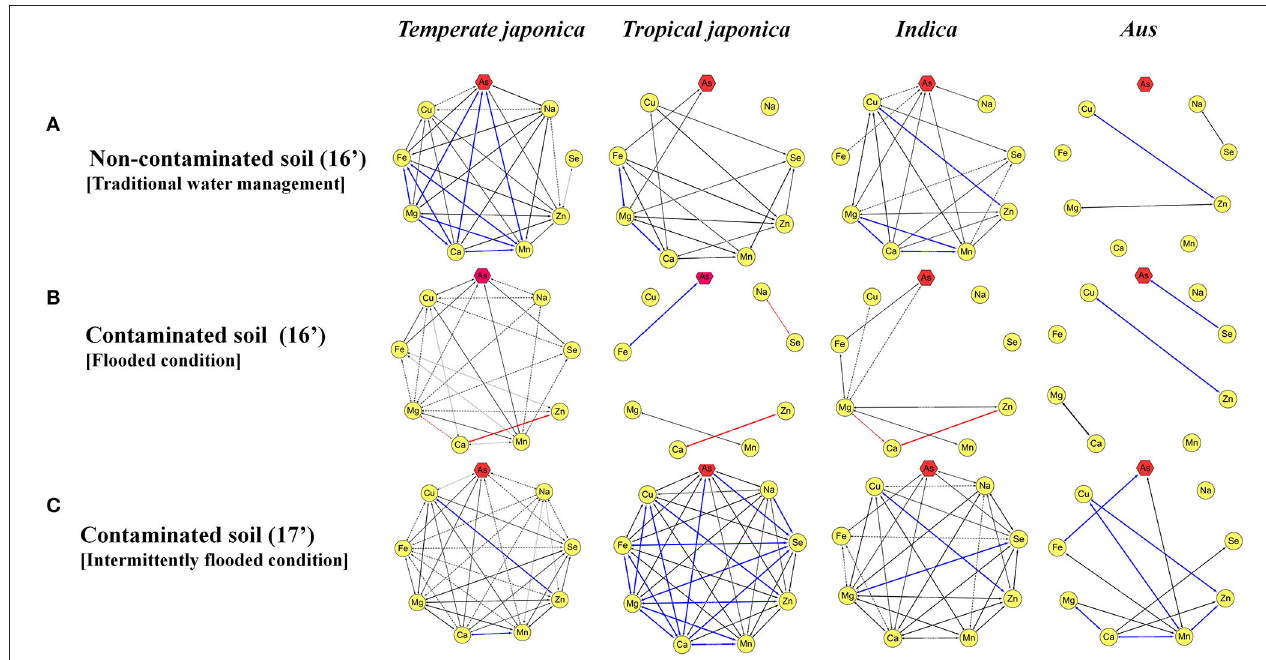
FIGURE 3 | Interaction between arsenic and other inorganic components. The correlation between ionomes was based on the Pearson coefficient value . Blue line: positive correlation (0.8 < r < 1.0), red line: negative correlation ( − 1.0 < r < − 0.8), black line: positive correlation (0.4 < r < 0.8), and dotted line: positive correlation (0.2 < r < 0.4). (A) The interaction between ionomes of 273 rice grains in non-contaminated soil. (B) The interaction between ionomes of 273 rice grains under the flooded condition in contaminated soil. (C) The interaction between ionomes of 273 rice grains under the intermittently flooded condition in contaminated